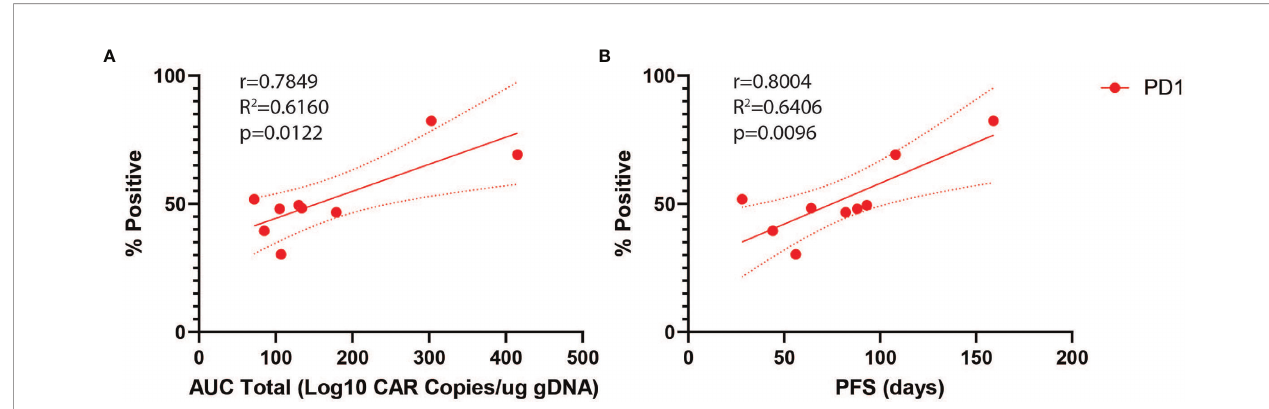
FIGURE 2 | PD1 Correlations for CD4 + CAR + Cells in Patient Transduction Products. Correlation of PD1 expression with clinical outcomes for CD4 + CAR + cells in patient transduction products. (A) Association between PD1 expression and total AUC. (B) Association between PD1 expression and PFS. Error bars shown are 95% con fi dence